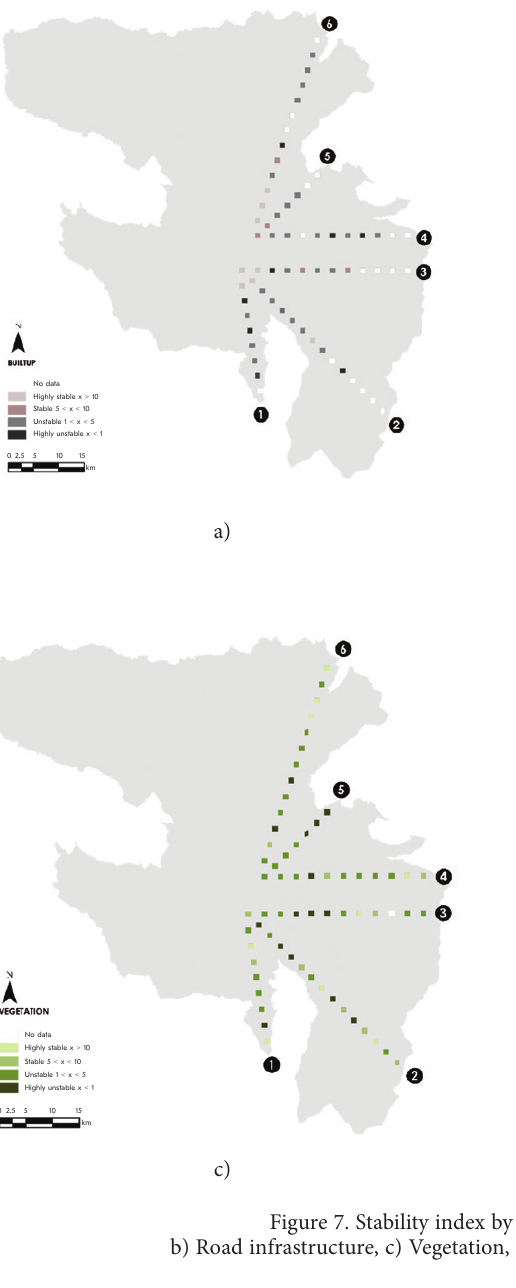
Table 2. Stability index (source: by the